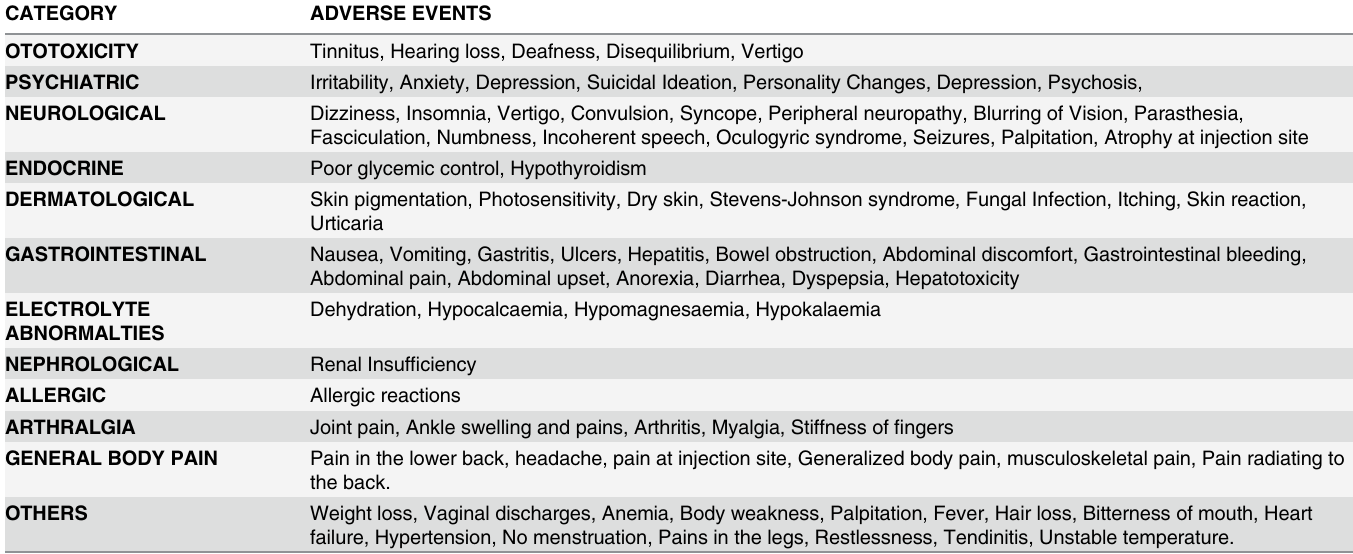
Table 1. Grouping of adverse events of second — line anti-tuberculosis drugs.